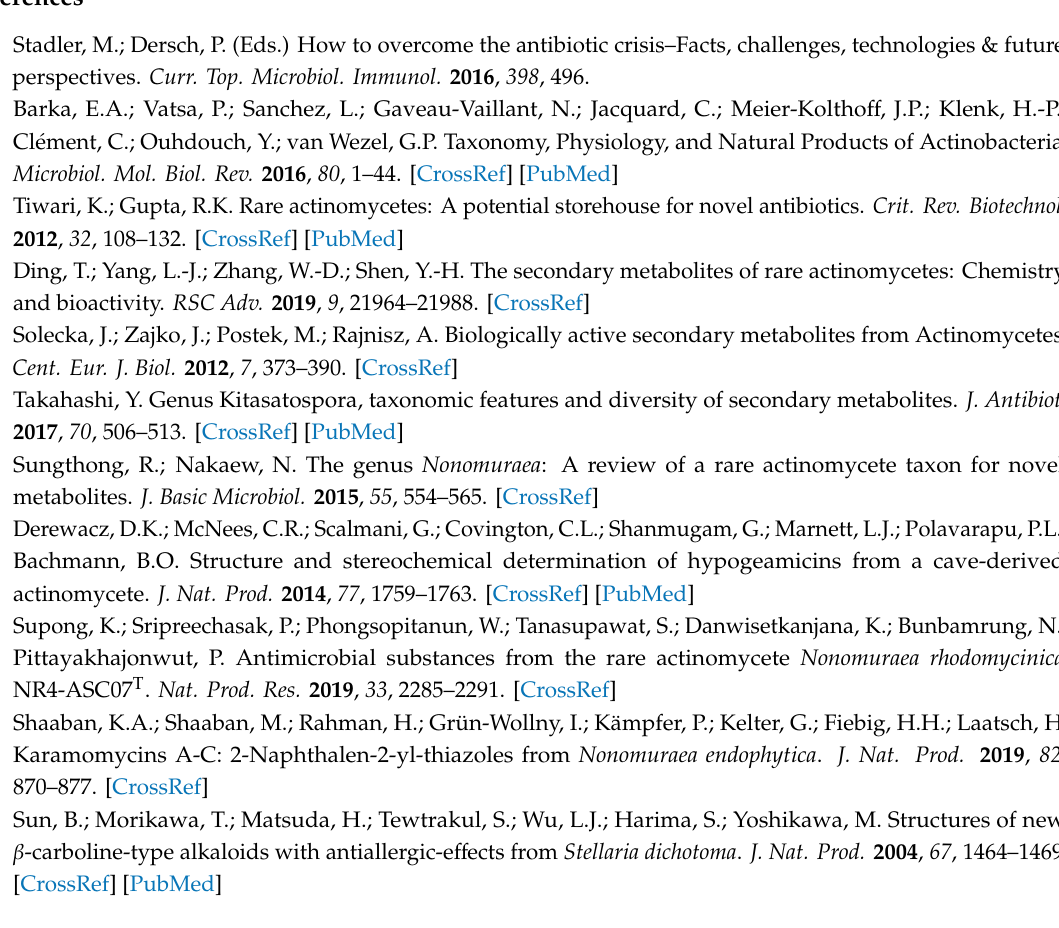
S40: 1 H, 13 C HMBC NMR of 4 in DMSO- d 6 , Figure S41: 1 H NMR spectrum of 5 in DMSO- d 6 , Figure S42: 13 C NMR spectrum of 5 in DMSO- d 6 , Figure S43: DEPT NMR of 5 in DMSO- d 6 , Figure S44: 1 H, 1 H COSY of 5 in DMSO- d 6 , Figure S45: 1 H, 13 C HSQC NMR of 5 in DMSO- d 6 , Figure S46: 1 H, 13 C HMBC NMR of 5 in DMSO- d 6 , Figure S47: 1 H, 1 H COSY NMR 1 H NMR reaction mixture of ( R )-nonocarboline D-MTPA ester in pyridine- d 5 , Figure S48: spectrum of reaction mixture of ( R )-nonocarboline D-MTPA ester in pyridine- d 5 , Figure S49: 1 H NMR reaction mixture of ( S )-nonocarboline D-MTPA ester in pyridine- d 5 , Figure S50: 1 H, 1 H COSY NMR spectrum of reaction mixture of ( S )-nonocarboline D-MTPA ester in pyridine- d 5 , Figure S51: Rection scheme and 1 H NMR chemical shifts after Mosher’s reaction, in the supplementary